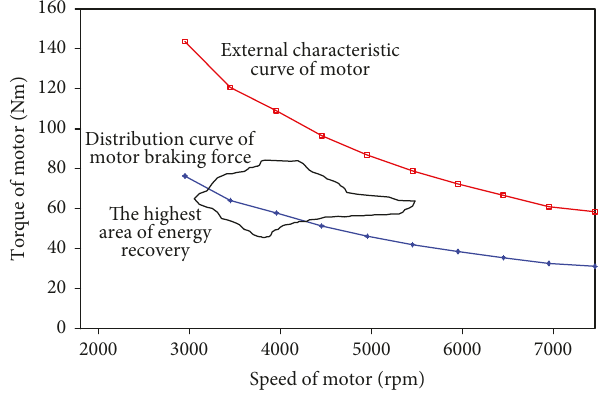
Figure 16: Maximum area distribution map of energy recovery e ffi